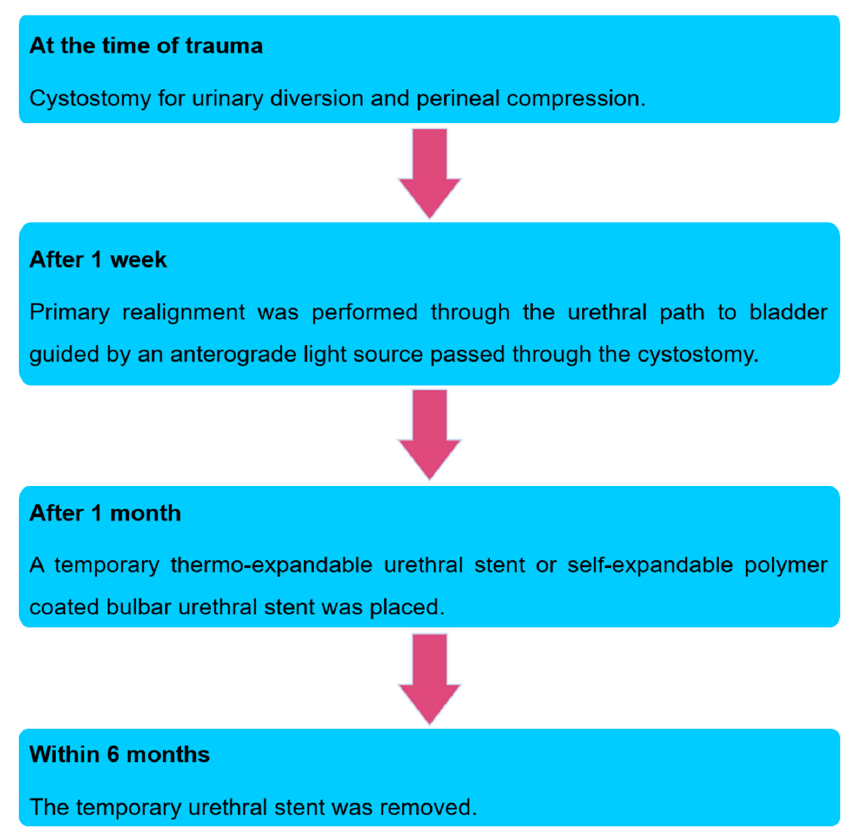
Figure 3. Treatment strategy algorithm.